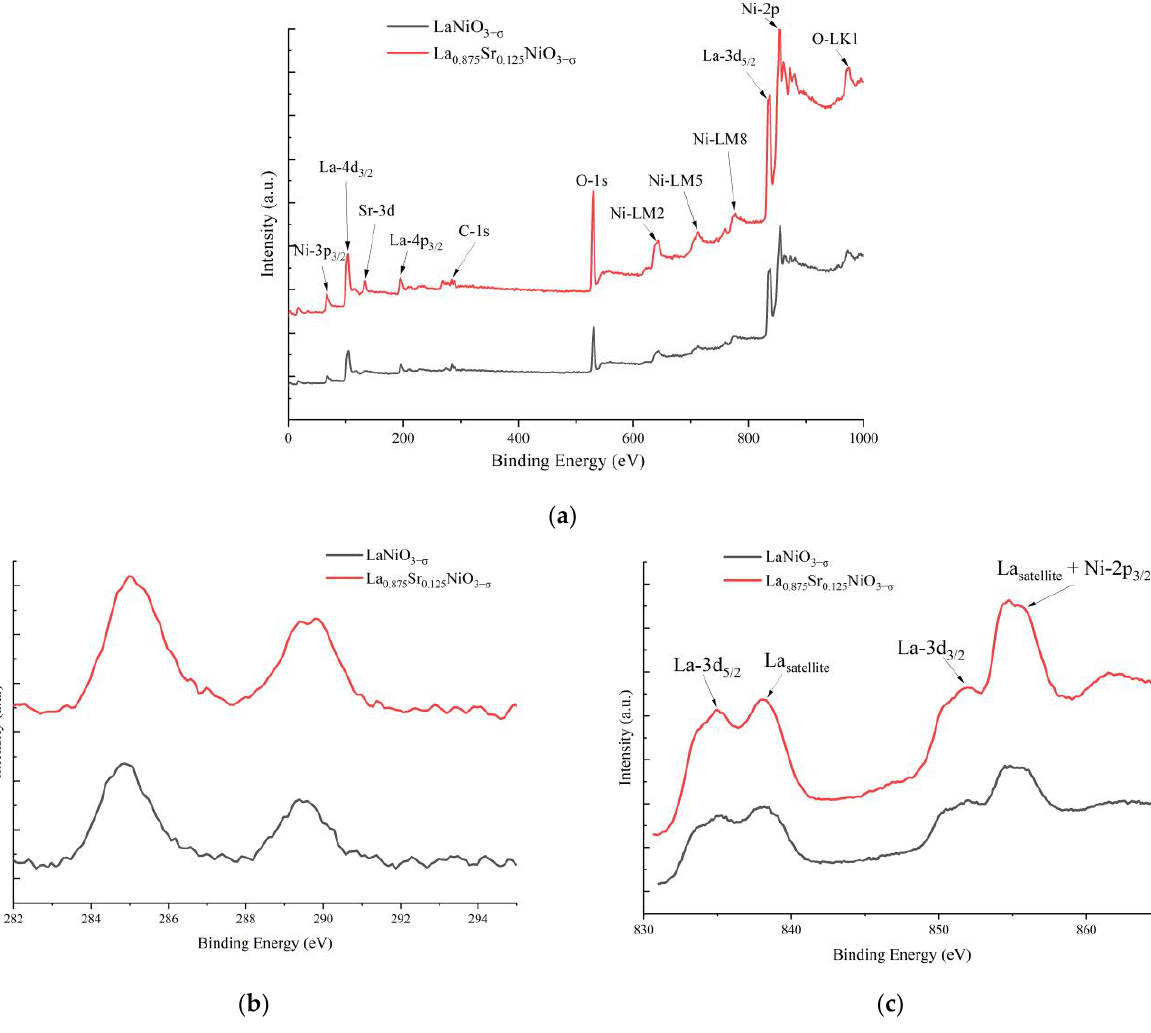
Figure 5. XPS spectrum of undoped and Sr-doped LaNiO 3−σ . ( a ) Full scan; ( b ) C-1s scan; ( c ) La-3d & Ni-2p scan.